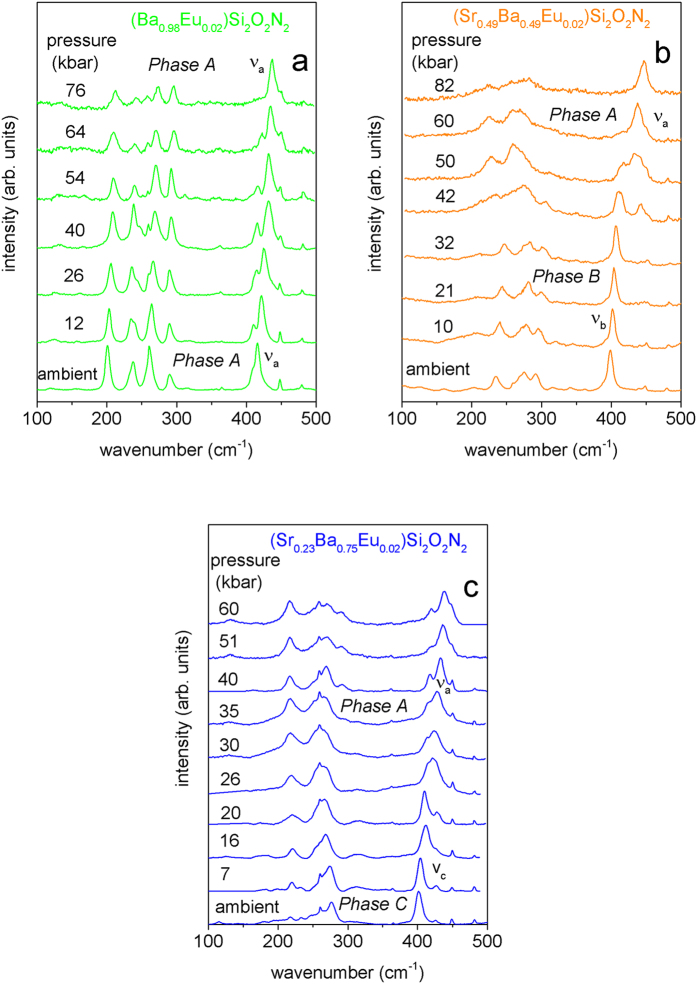
Raman spectra of the (Sr0.98-xBaxEu0.02)Si2O2N2 for (a) x = 0.98 (b) x = 0.49 and (c) x = 0.75 at different pressures.